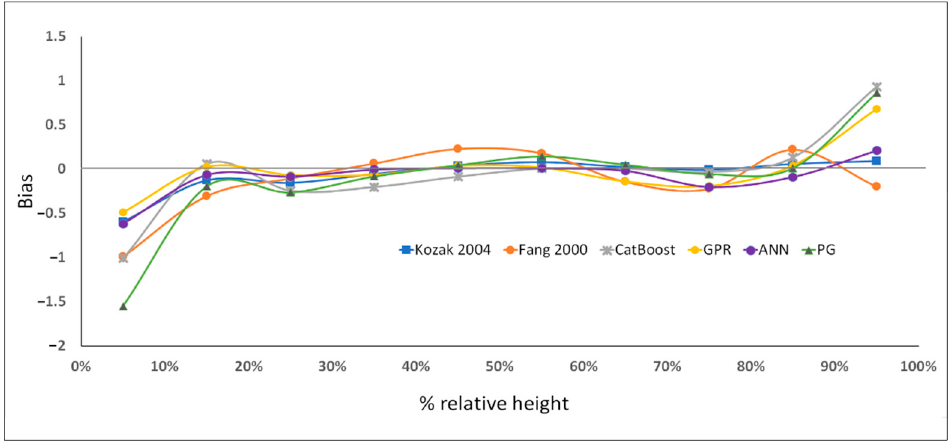
Figure 5. Tendency of bias for 10% relative heights intervals along the